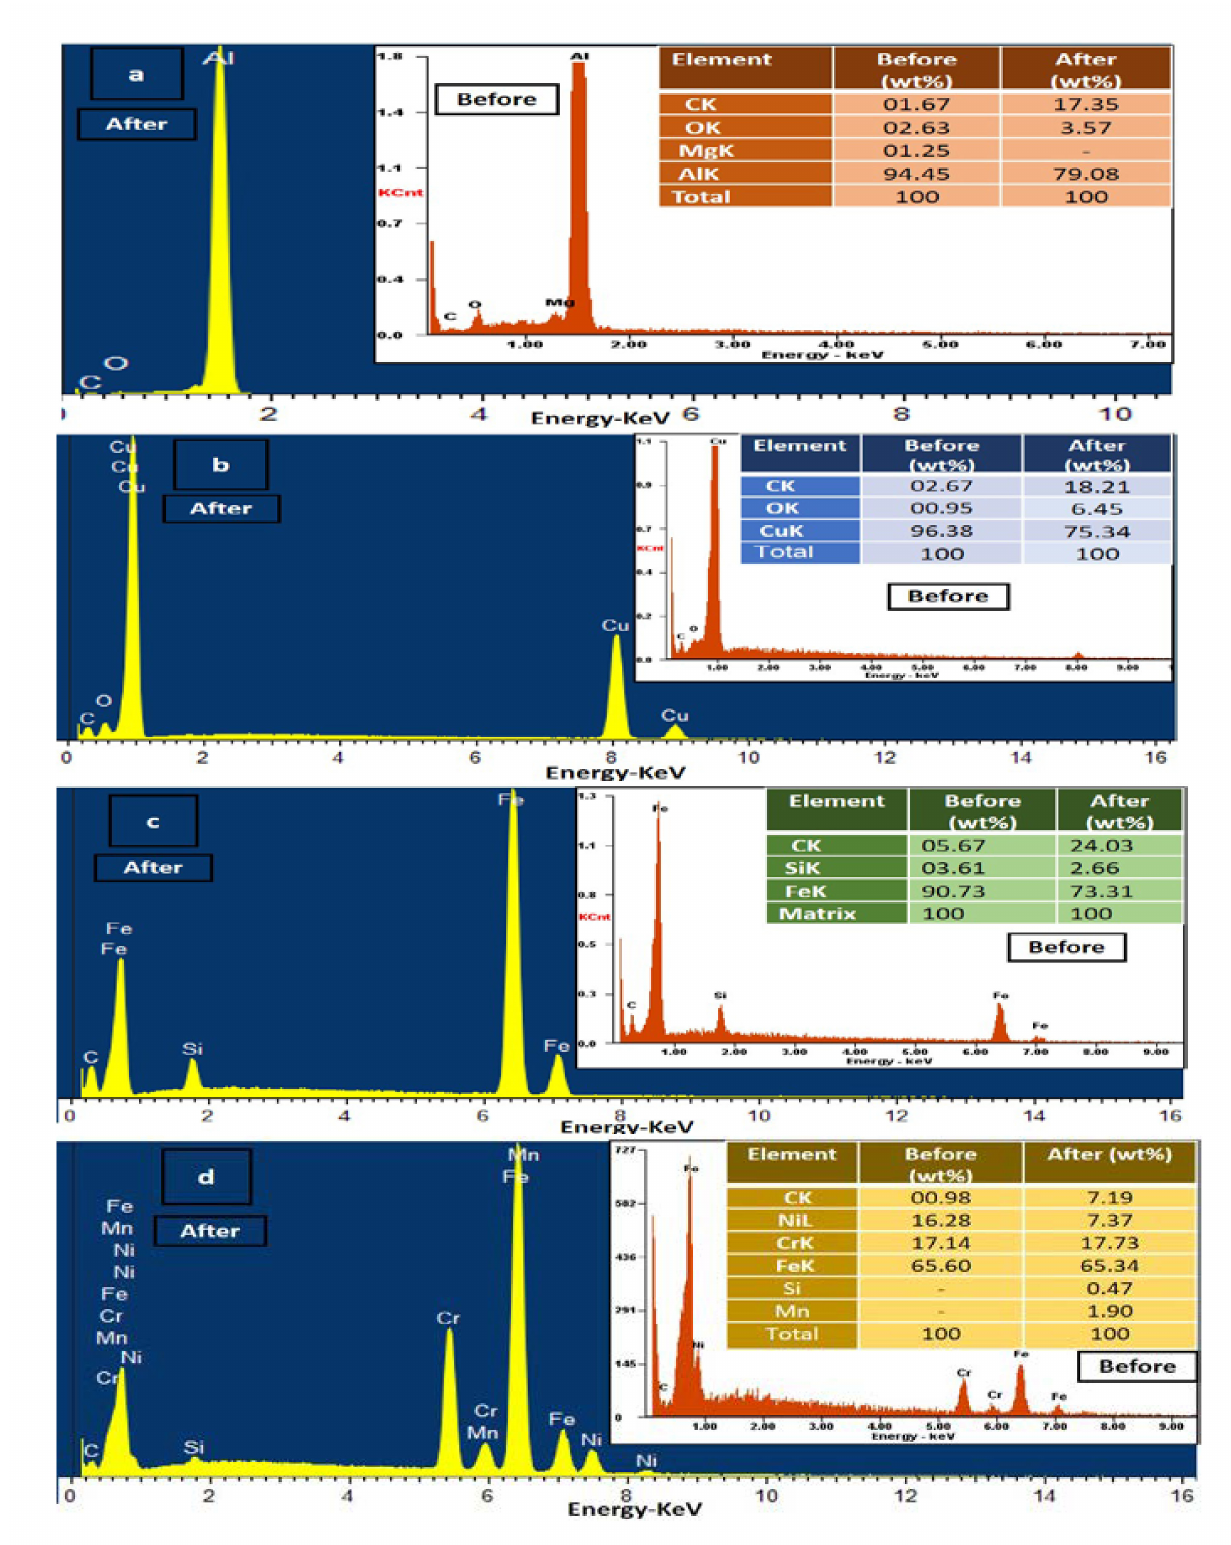
Figure 5. Elemental analysis of different materials immersed into B20 after the immersion test: ( a ) Al, ( b ) Cu, ( c ) CI, and ( d )